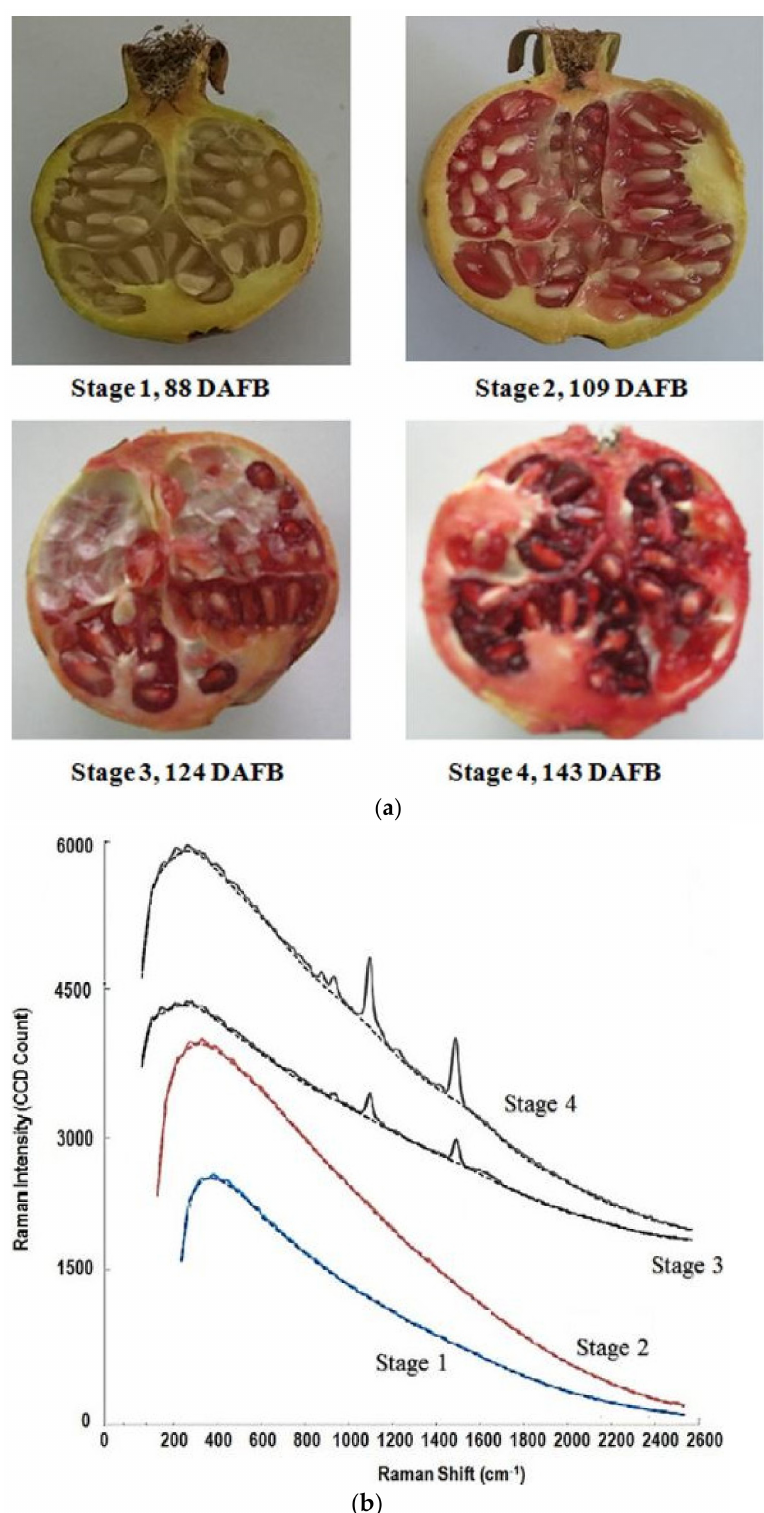
Figure 3. ( a ). Fruit samples and arils of pomegranate (Ashraf cultivar) at different maturity stages. Immature stage (88 days after full bloom (DAFB), half-ripe stage (109 DAFB), fairly half-ripe stage (124 DAFB) and fully ripe stage (143 DAFB). Adapted from [85]. ( b ). A Raman spectra profile of four different maturity stages of intact pomegranate fruit at different maturity stages. Stage 1 (88), stage 2 (109), stage 3 (124) and stage 4 (143) (DAFB). Adopted from